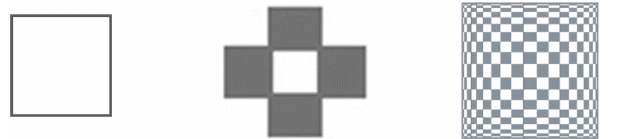
Figure 11. Evolution of the fourth pattern.